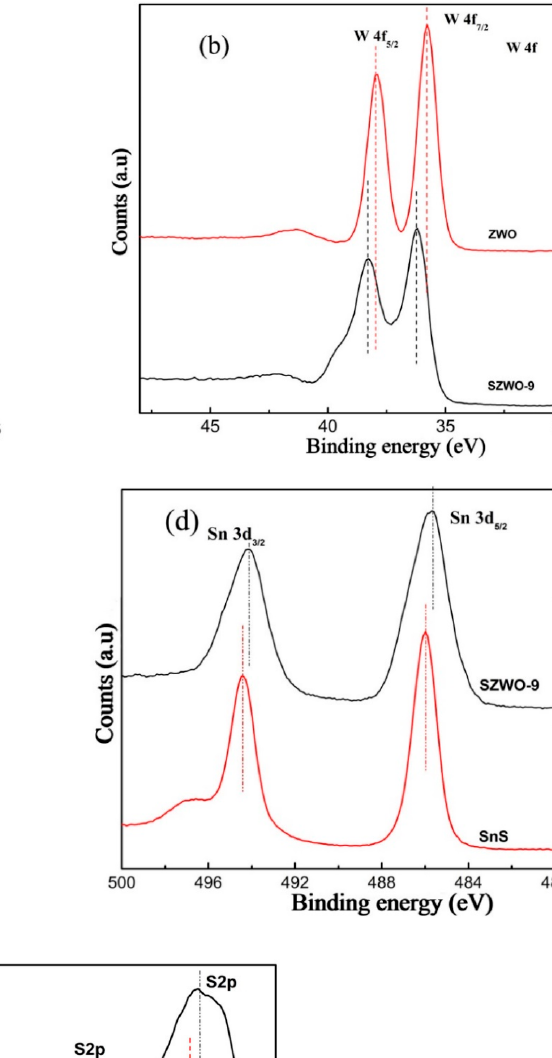
Figure 3. XRD patterns of ZWO, SnS and SnS/ZWO hybrid composites.